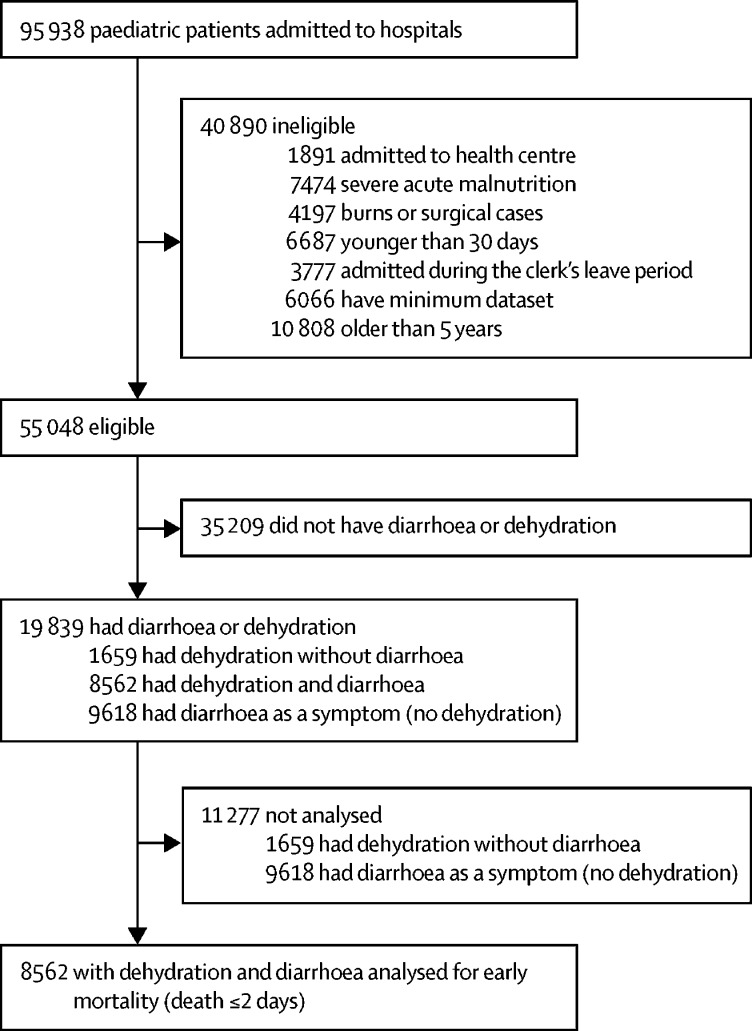
Study profileCIN=Clinical Information Network.